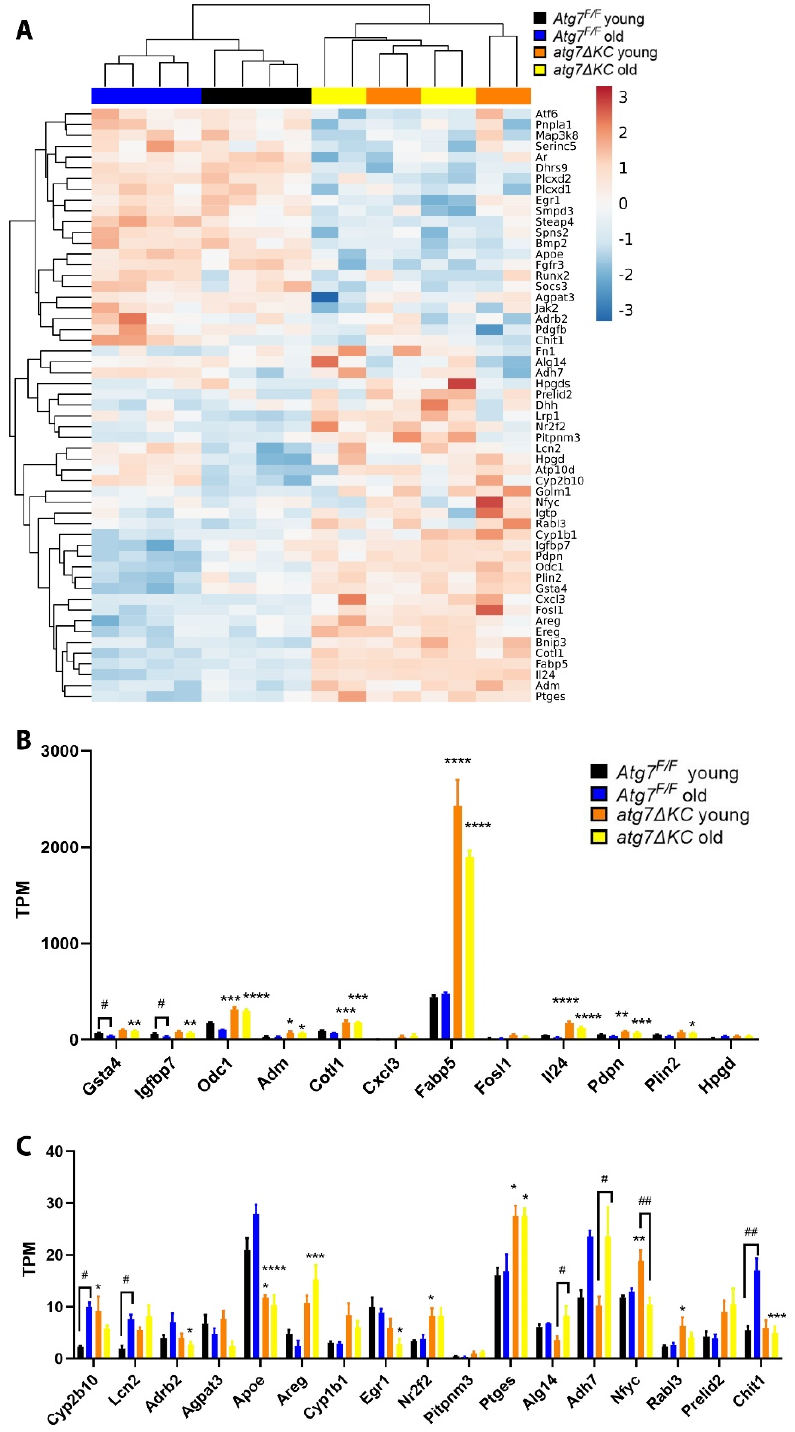
Figure 3. Expression of genes with a function in lipid metabolism-localisation or-signalling in cultured epidermal keratinocytes from young and old Atg7 F/F or atg7 ∆ KC. ( A ) The heatmap of selected 55 lipid- related candidate genes. B and C Bar graph representation of DEG where at least one condition displayed a “Transcripts Per Kilobase Million” (TPM) value of more than 50 ( B ) or between 10 and 50 ( C ). * marks a significant difference between Atg7 F/F and atg7 ∆ KC, # shows a significant difference between young and old groups; */# p < 0.05; **/## p < 0.01; *** p < 0.001; **** p < 0.0001; n = 4 (for each group).